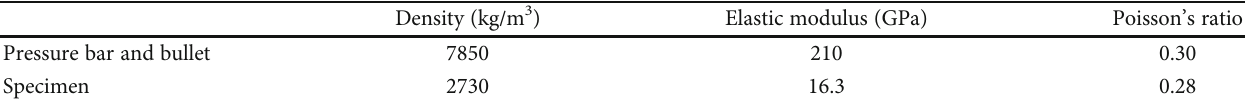
Table 2: Model parameter